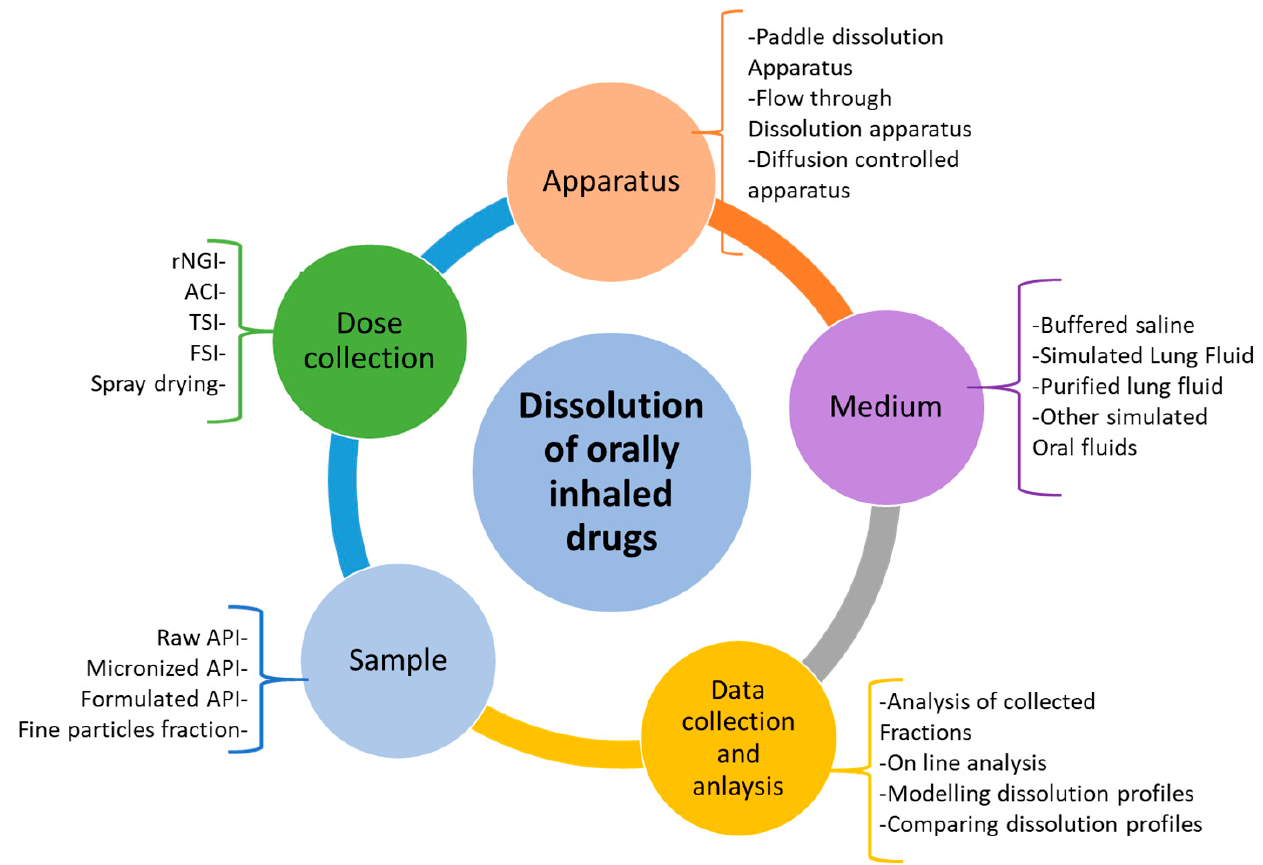
Figure 2. Potential stages of dissolution testing and parameters involved in each stage for the dissolution of inhaled compounds (rNGI = reduced next generation impactor; ACI = Anderson cascade impactor; TSI = twin stage impinger; FSI = fast screening impactor).